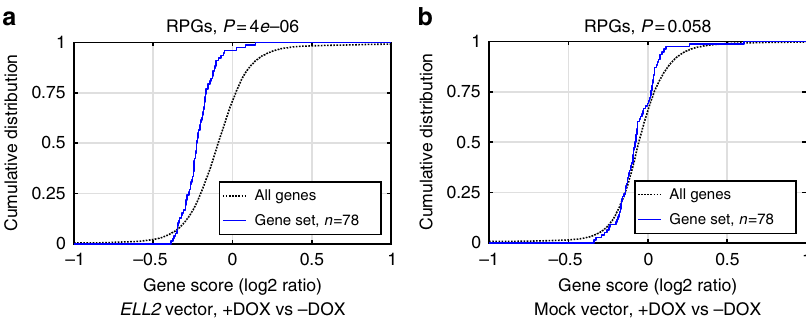
Fig. 5 Reconstitution of ELL2 expression. For further validation of the effect of ELL2 knockout on RPG expression, we transduced CRISPR-resistant, doxycycline-inducible ELL2 or mock vector into our L363- ELL2 -KO cells. Following culture with or without doxycycline (DOX), the cells were gene expression-pro fi led using mRNA sequencing: a Comparing the gene expression pro fi les of ELL2 -transduced cells cultured with ( n = 3) vs without DOX ( n = 4), we observed an enrichment of negative gene scores (i.e., downregulation) of ribosomal gene sets, consistent with a rescue effect; b no similar enrichment was seen with mock-transduced control cells ( n = 4 samples with vs 4 without DOX). These data further support a cause – effect relationship, and that the results in Fig. 4b are not due to CRISPR-Cas9 off-target